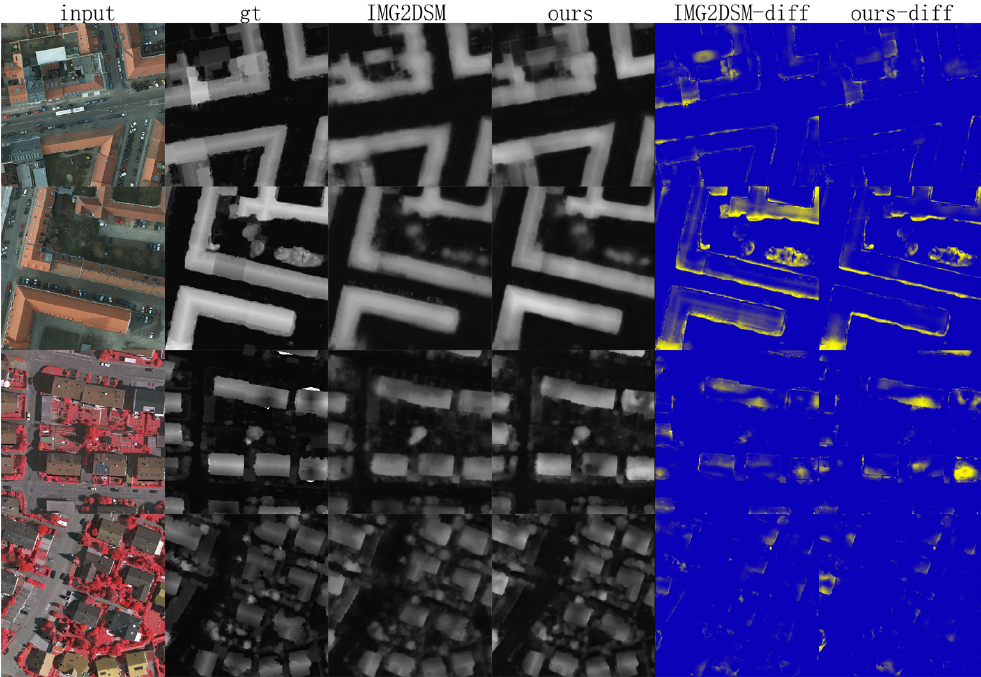
Figure 4. Two examples from the Potsdam dataset (top two rows) and two examples from the Vaihingen dataset (bottom two rows). From left to right, we show the input images, ground truth, predicted height maps of IMG2DSM (our implementation), predicted height maps of our method, height difference maps using IMG2DSM, and height difference maps of our result, respectively. Table 1. Comparison height estimation results in supervised learning mode with the previous